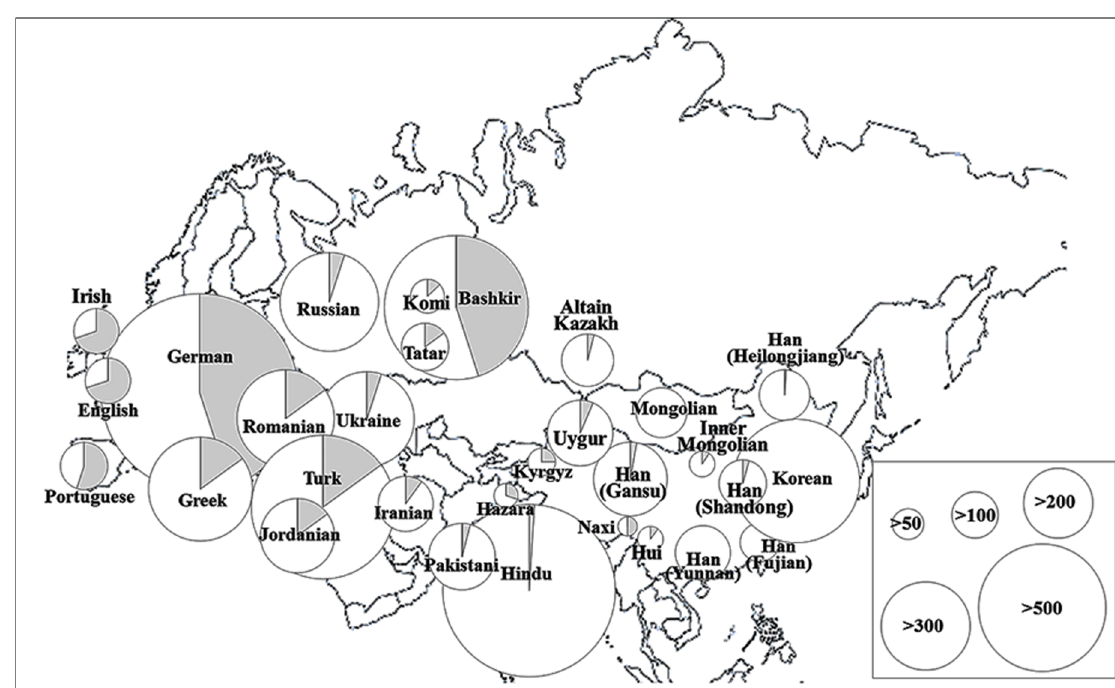
Fig 3. Geographic distribution of modern-day populations with haplogroup R1b-M343. Each circle represents a population sample; the area of the circle is proportional to the sample size. Black sectors denote the relative frequency of R1b- M343-carrying groups identified in the